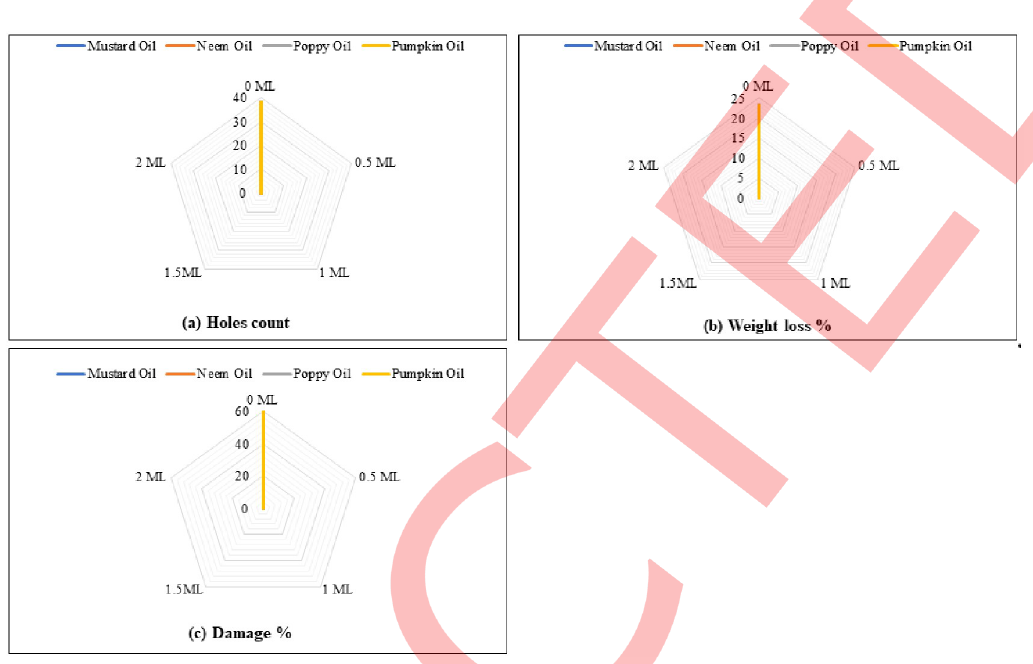
per 100 g grains with three days exposure. Neem oil contains azadirachtin, which is highly potent against C . maculatus .Ahmed et al. [32] stated that 100% mortality of C . chinensis was achieved within three days. Sousa et al. [33] assessed the comparative potency of mustard pupal, and adult stage) by using formulation response bioassays. The findings expressed that were highly susceptible compared to immature phases.